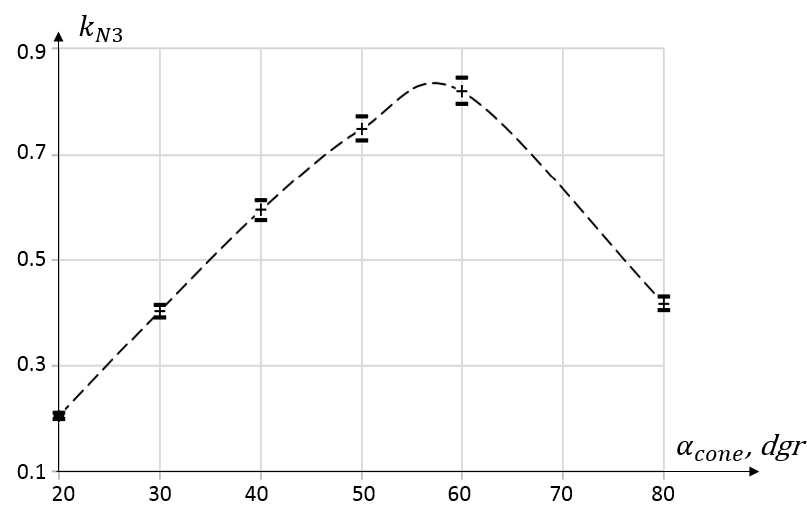
Figure 10. Influence of the inclination angle of conical part α cone on the power consumption factor of mixer k N 3 (experimental data).